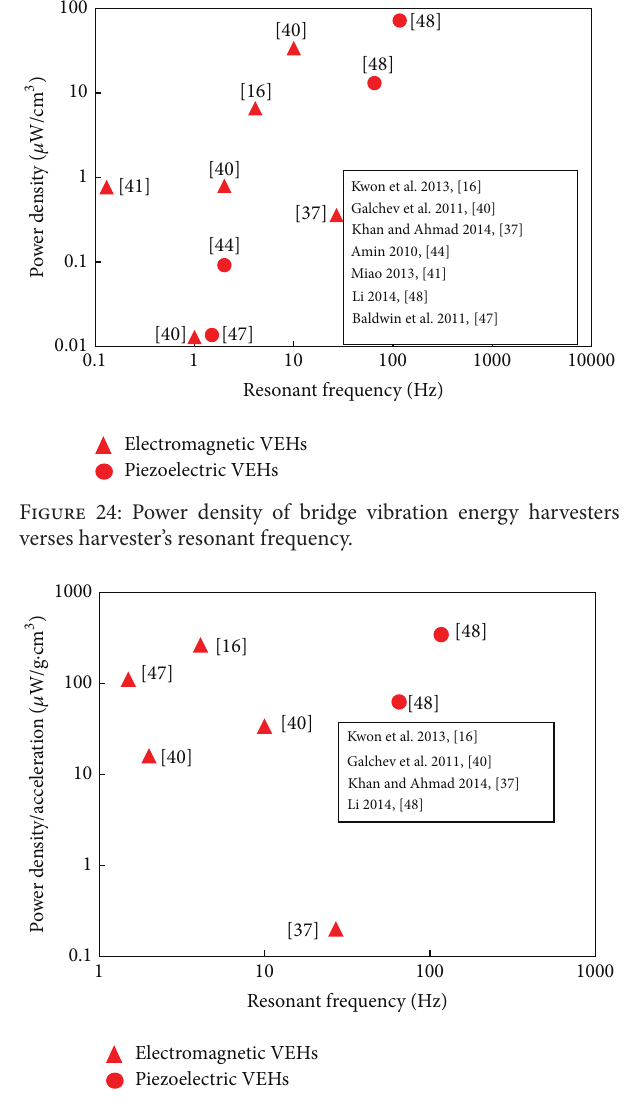
Figure25:Powerdensityperaccelerationofbridgevibrationenergy harvesters verses harvester’s resonant